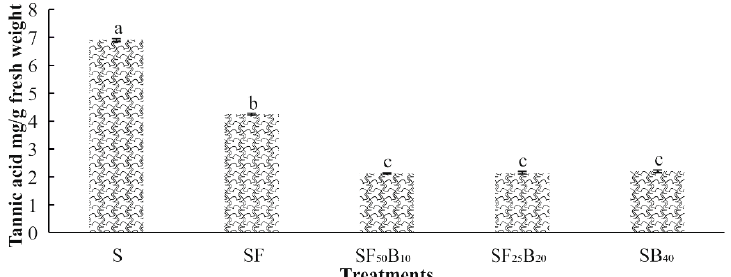
Figure 2. Total phenolic compounds in basil ( Ocimum basilicum L.) cultivated in a soil with treatments,